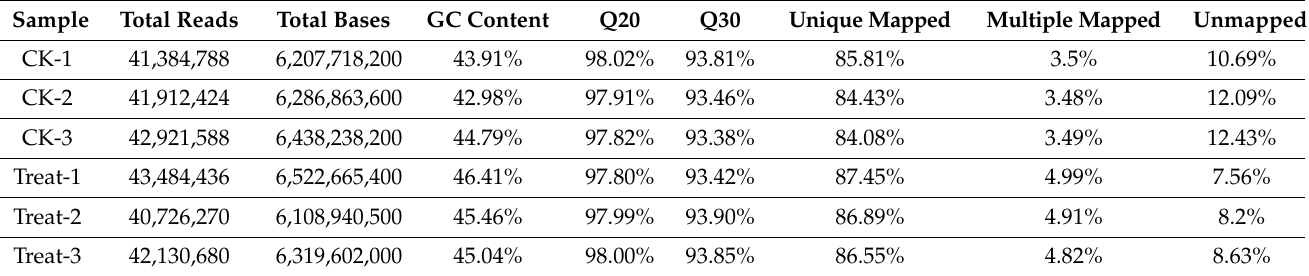
Table 1. The statistics of transcriptome profile and the mapping